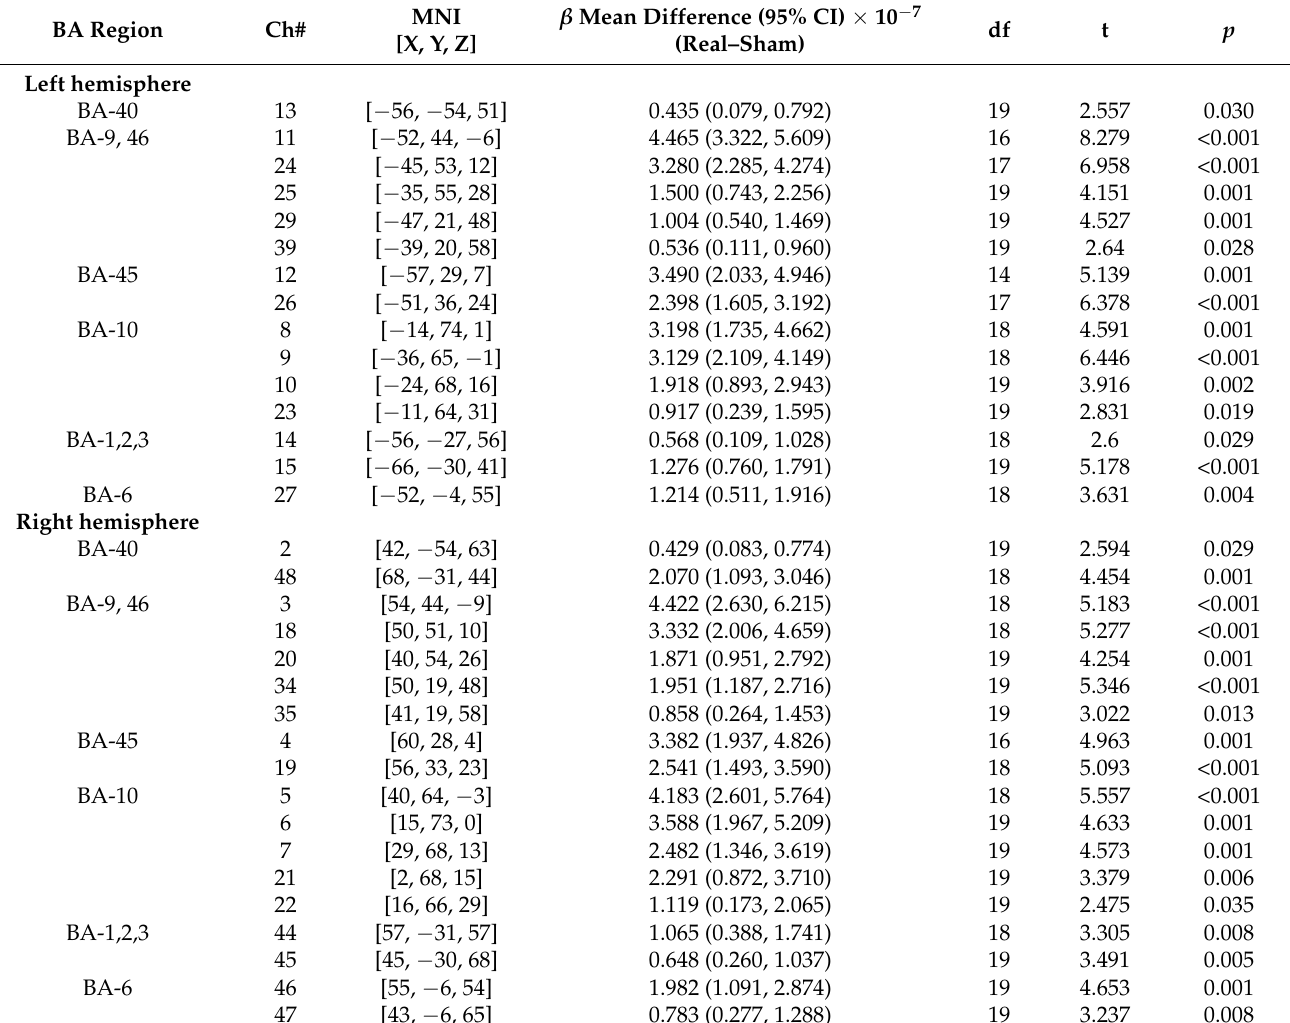
Table 1. Real versus sham mPES-related cortical activation during immediate